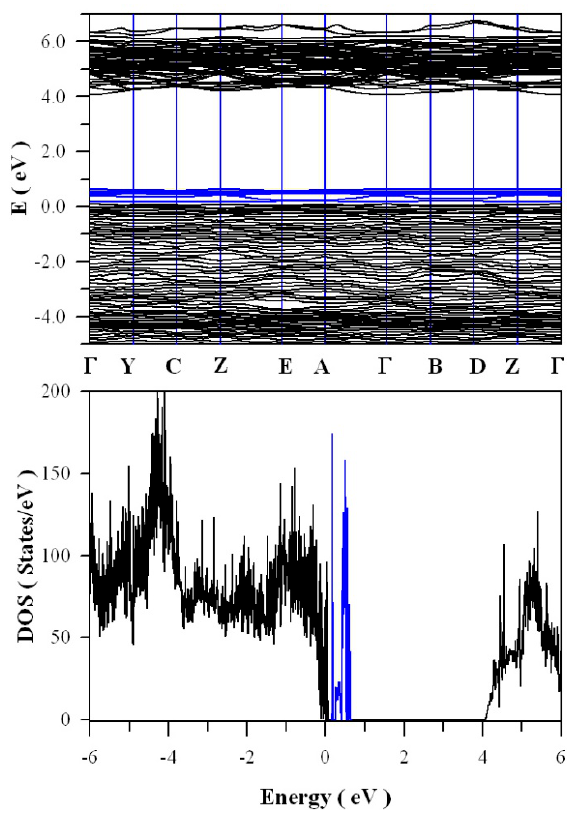
Figure 13. DFT calculated electronic structures for tungsten deficient ZnWO 4 (ZnW 1 − δ O 4 where δ = 0.0625): ( a ) band structure; and ( b ) density of states.